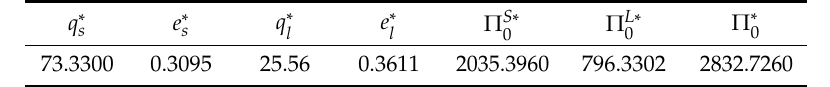
Table 1. Supply chain network benefit equilibrium variables under compliance conditions.